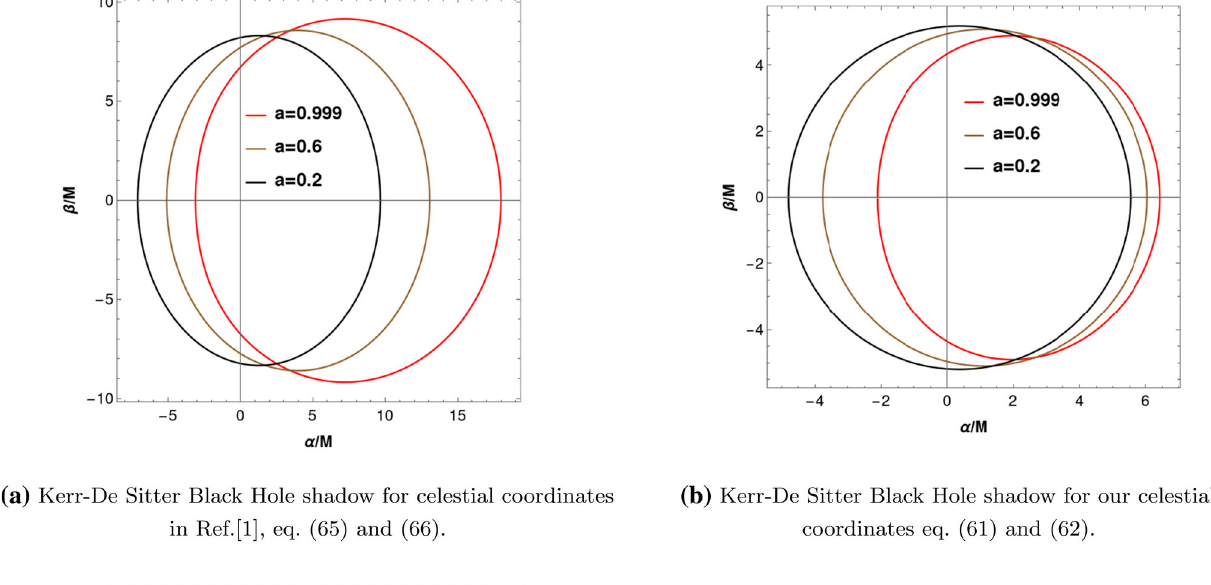
3. The vertical diameter, (cid:7)β = 2 β T . 4. Horizontal diameter, (cid:7)α =